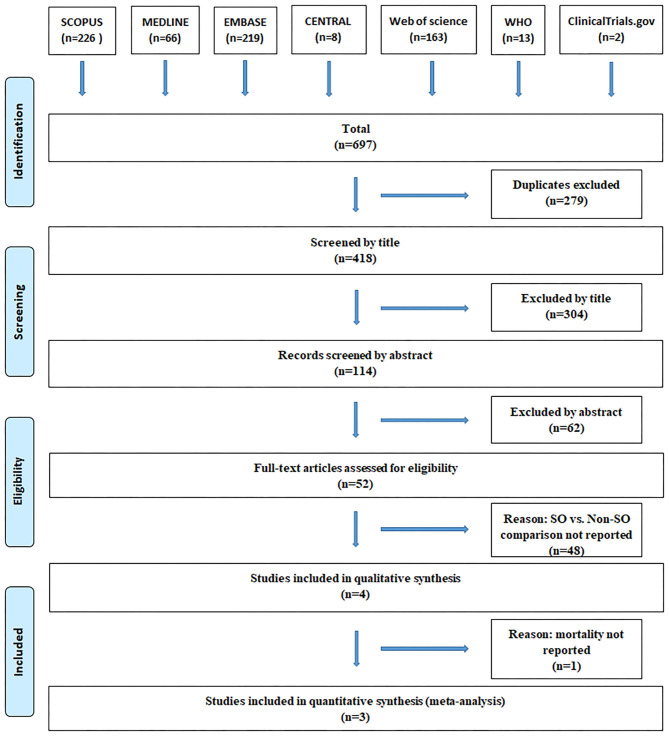
PRISMA flowchart.